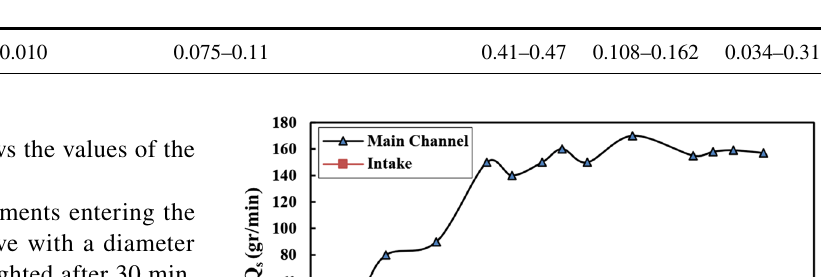
Fig. 4 A schematic view of flume, spur dike, skimming wall and sediment bed Table 2 The parameter range in this study Parameters